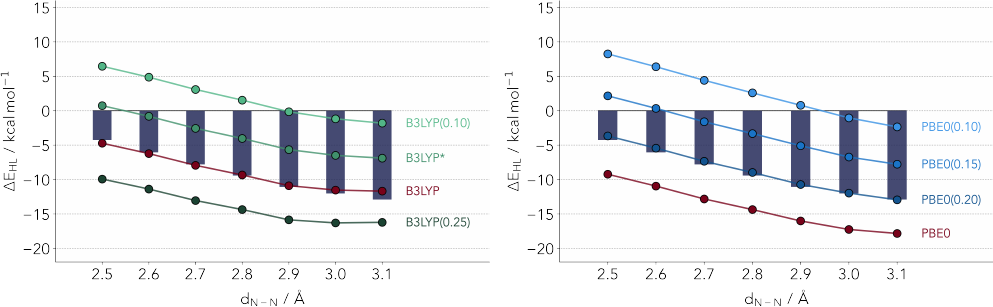
Figure 3. Comparison of ∆ E HL values computed with refitted B3LYP ( left panel ) and PBE0 ( right panel ) functionals. The bars depict the reference coupled cluster